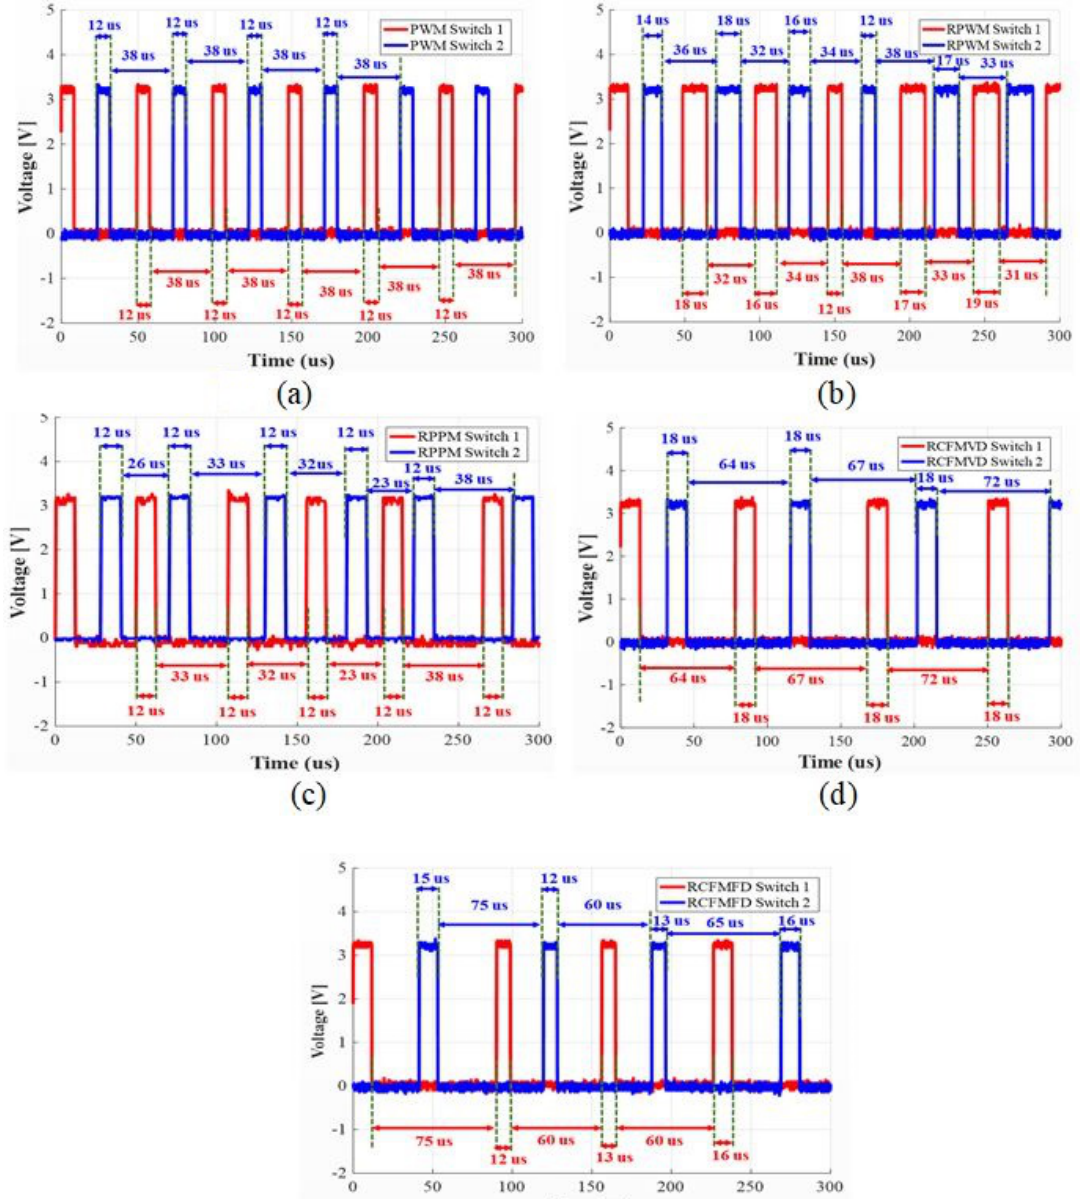
Figure 6. Switching modulation signals from Arduino for the interleaved buck converter operation: ( a ) PWM, ( b ) RPWM, ( c ) RPPM, ( d ) RCFMVD, and ( e )